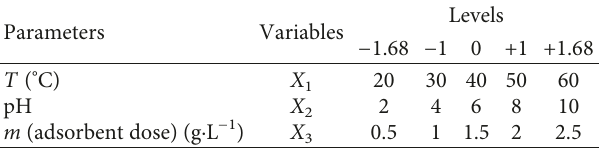
Table 2: Description of the variables and their levels.